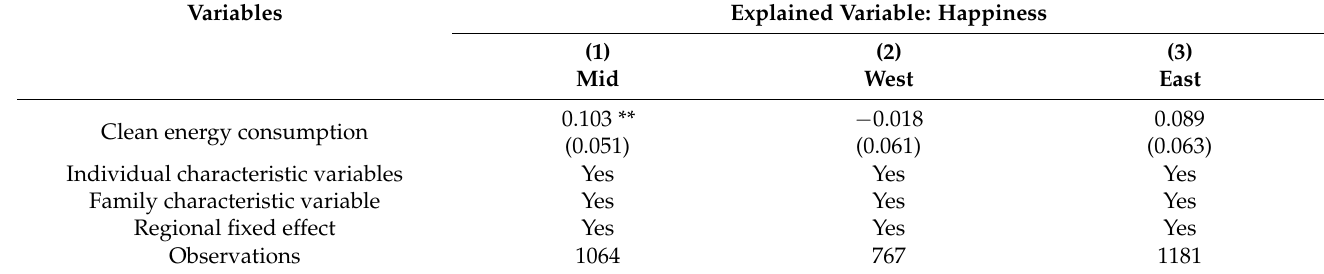
Table 9. Heterogeneity analysis from the perspectives of